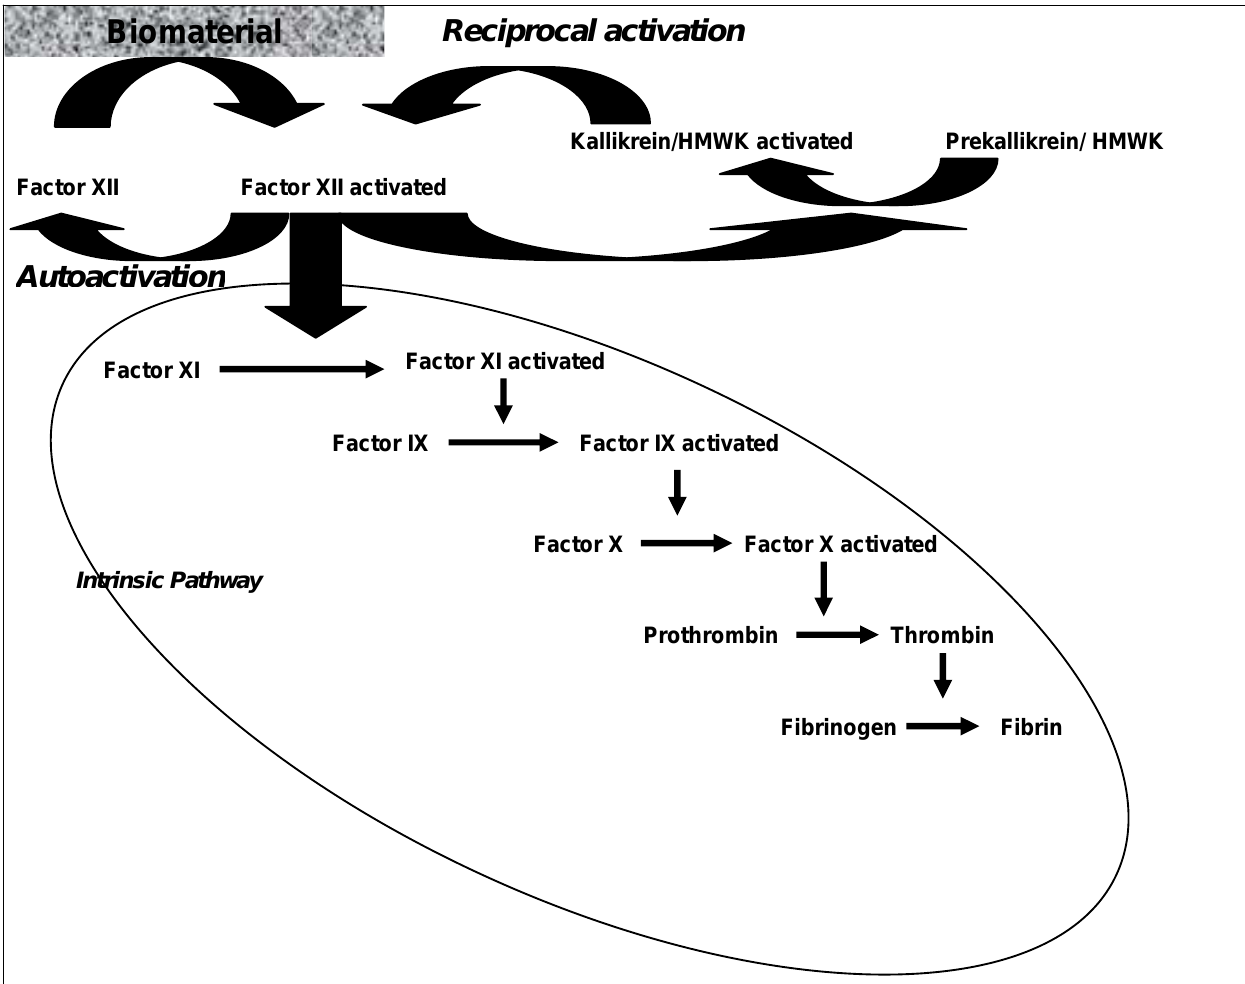
Figure 1. Activation of the coagulation system is initiated by biomaterial-protein interaction. Activation of factor XII is the initial step. Reciprocal activation and autoactivation lead to amplification of activated factor XII, which in turn initiates the intrinsic coagulation pathway via activation of factor XI, leading ultimately to the production of fibrin (details see in the